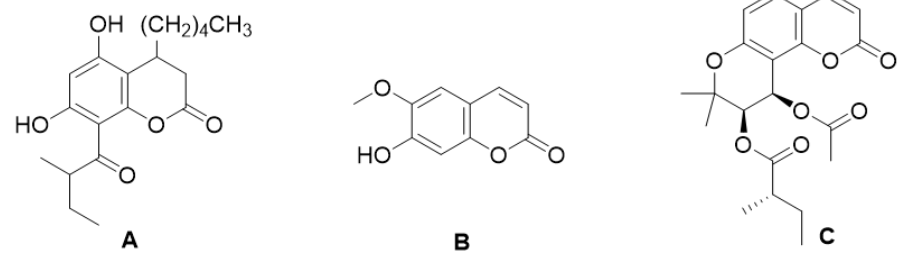
Figure 8. Chemical structures of dihydrommamea ( A ), scopoletin ( B ), visnadine ( C ).